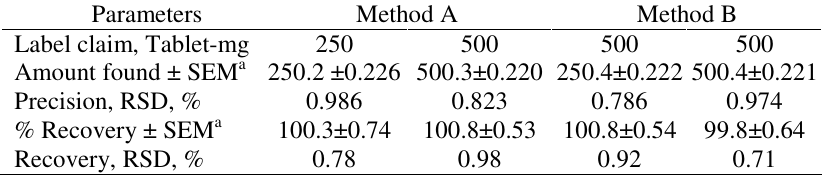
Table 2. Summary of validation